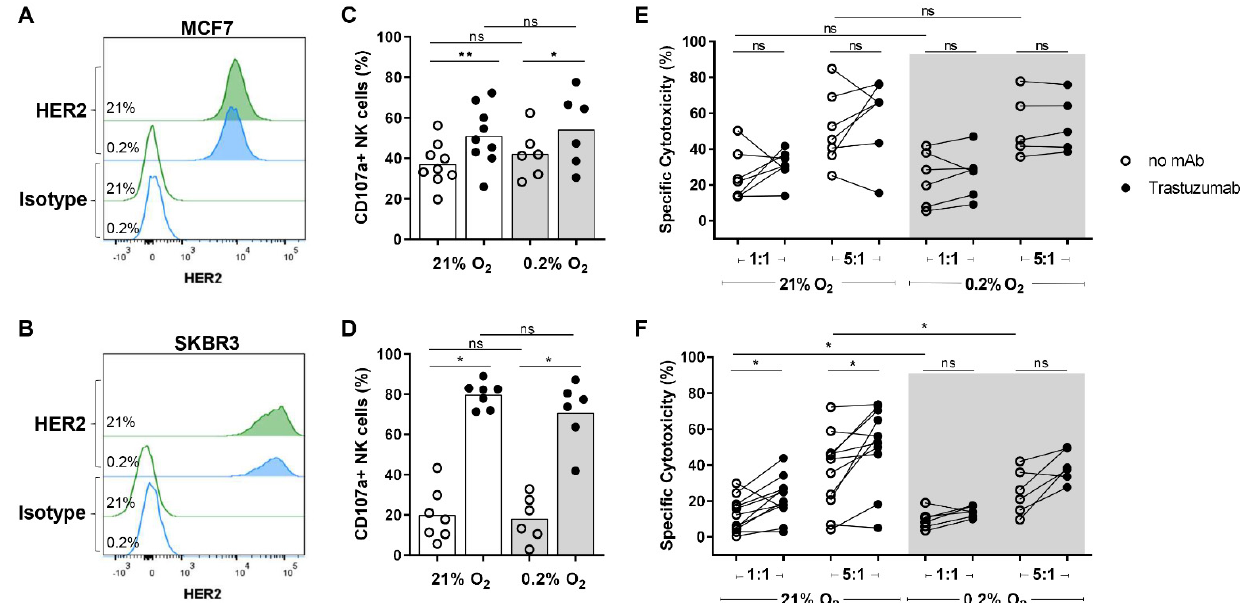
Figure 1. NK cell efficacy against non-amplified and HER2 amplified cell lines with or without trastuzumab under normoxia (21% O 2 ) and hypoxia (0.2% O 2 ). ( A , B ) HER2 surface expression levels were determined by flow cytometry on